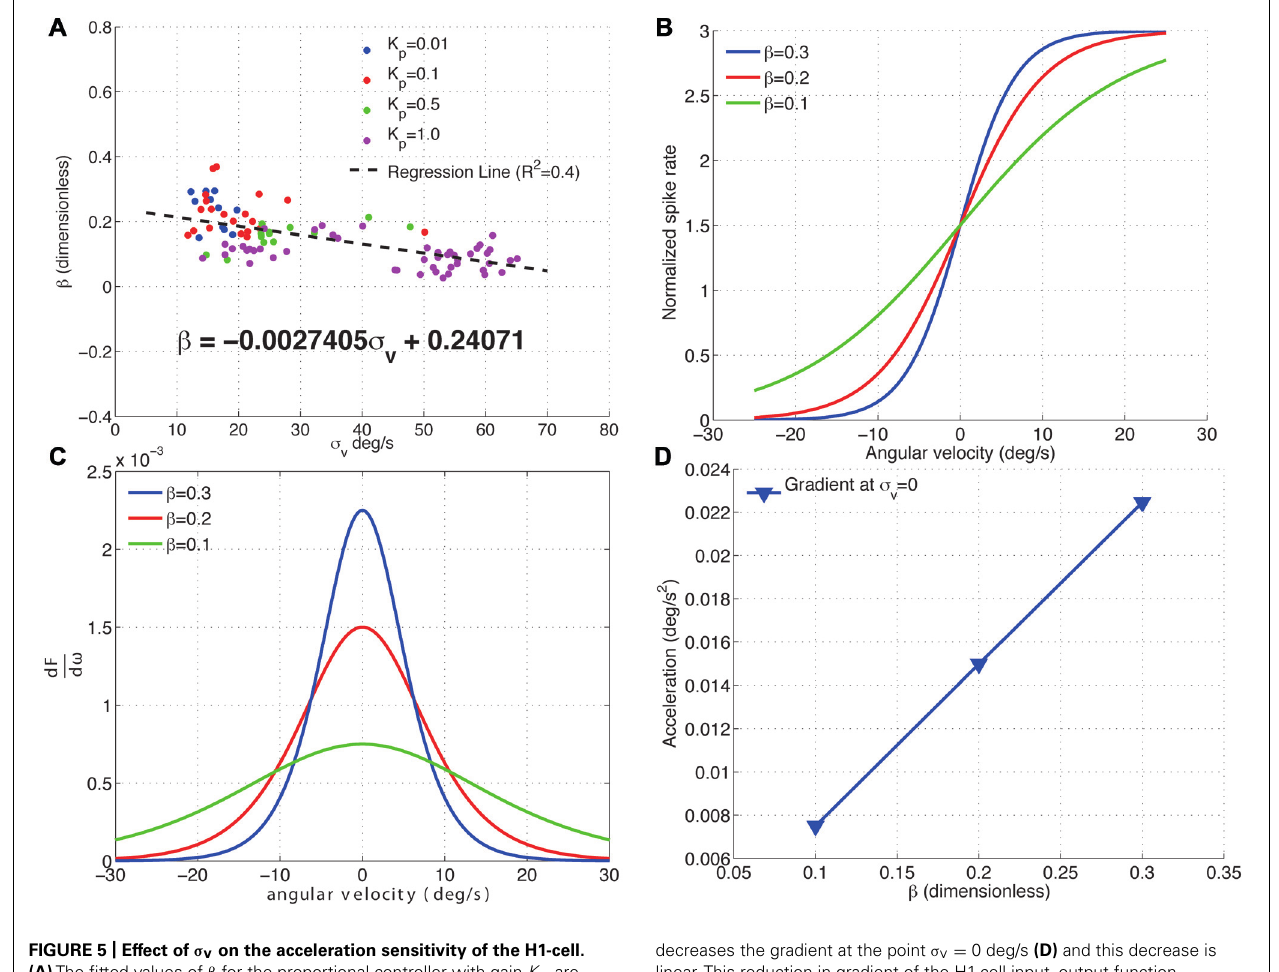
FIGURE 5 | Effect of σ v on the acceleration sensitivity of the H1-cell. (A) The fitted values of β for the proportional controller with gain K p are plotted against the standard deviation of the velocity distribution, σ v . Increasing σ v linearly decreases β as per the relationship specified by the regression line. (B) The input–output functions for three different values of β (normalized by the peak spike rate, F ) show that (C) decreasing beta linearly